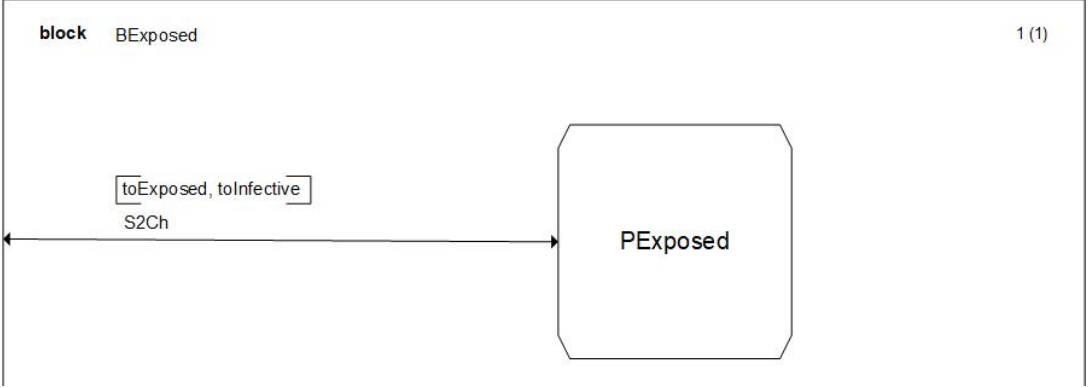
Figure 6. BLOCK diagram for BExposed .